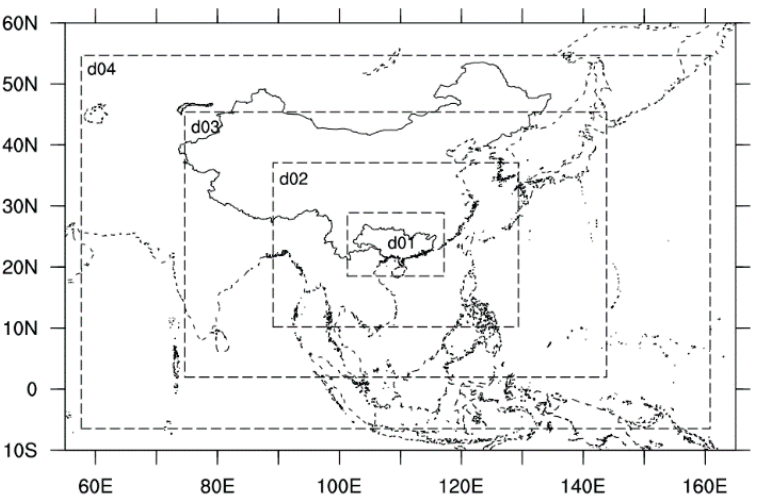
Fig. 1 The designations of simulations with different domain